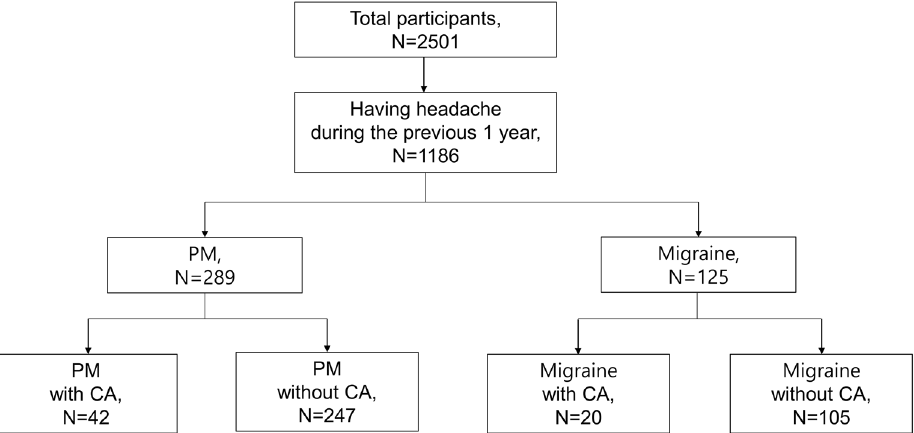
Figure 1. . Flow chart depicting the inclusion of participants in the study. CA cutaneous allodynia, PM probable migraine.